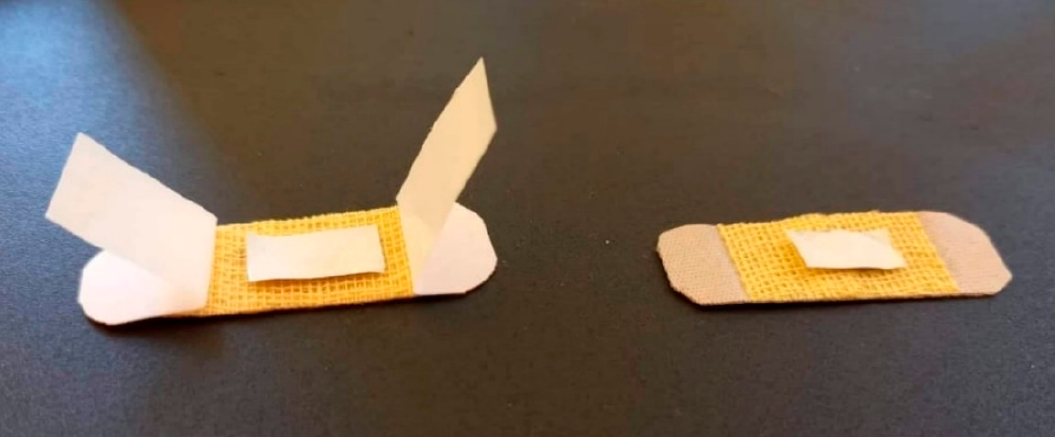
Figure 14. Photograph of prepared nanofiber samples before animal testing. Reproduced from Rapa et al. [116] under a Creative Common CC BY license.